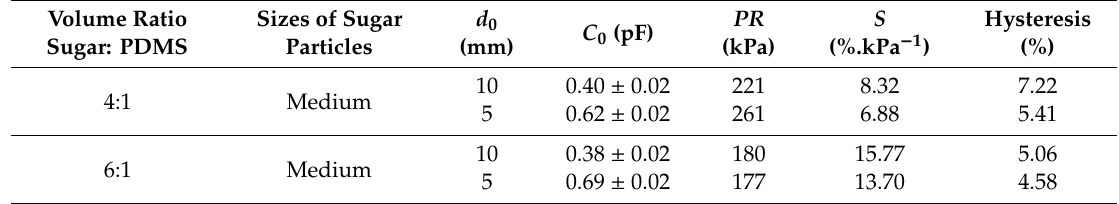
Table 4. Summary of the characterization results for the 6:1 medium pore PDMS foam based sensor for the load applied continuously and discontinuously ( d 0 = 5 mm ± 0.5